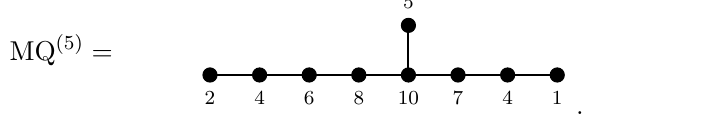
defined by x 2 X